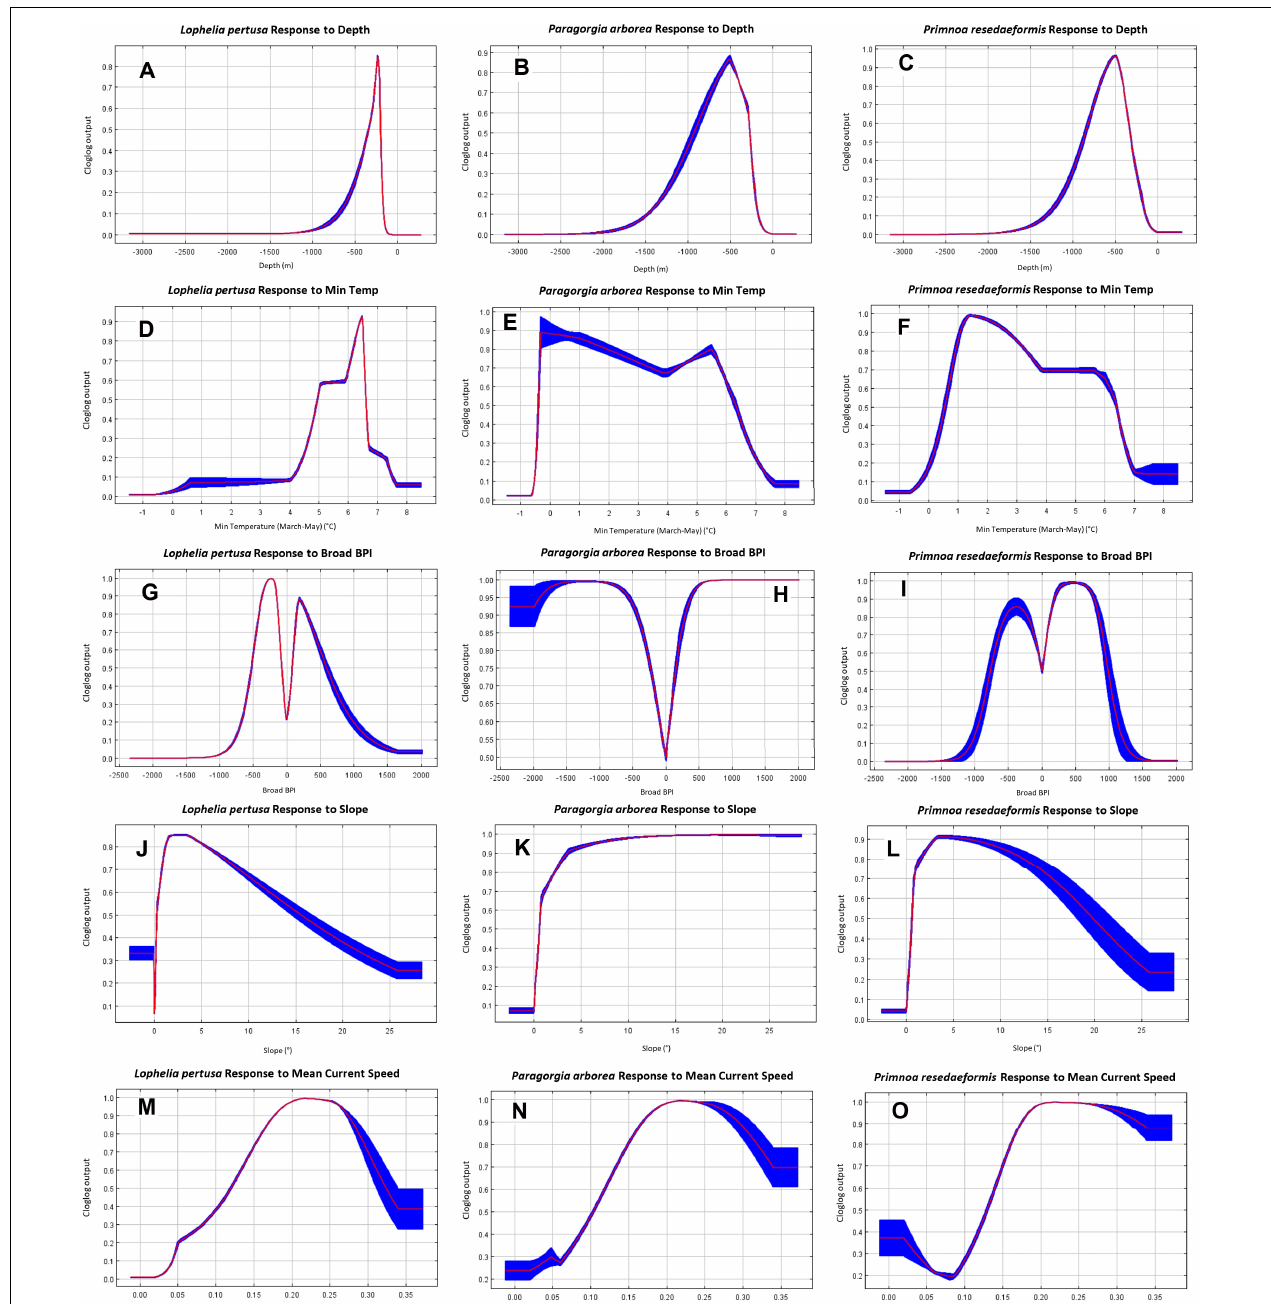
FIGURE 8 | Model 2 individual variable response curves of each species for depth (A–C) , minimum temperature (D–F) , broad BPI (G–I) , slope (J–L) , and mean current speed (M–O) .